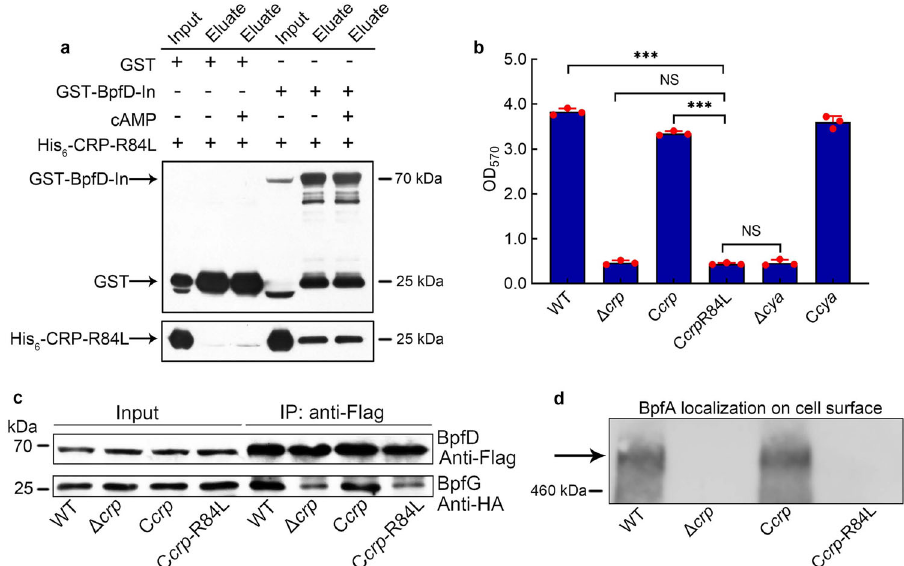
Fig. 6 cAMP is not necessary for physical interaction between CRP and BpfD, but it is essential to help CRP enhance the interaction between BpfD and BpfG. a GST pull-down assay showing the interaction between BpfD intracellular domains and CRP-R84L in vitro. b Bio fi lm biomass ( n = 3 independent samples). c Co-IP to analyze the interaction between BpfD and BpfG in vivo. d Western blotting detection of BpfA localization on the cell surface. All strains used in ( a , c , d ) were cultured for 30 h in the bio fi lm state. The native promoter region of the bpfA operon of the strains used in ( c , d ) was replaced by the constitutive promoter P aacC1 . Data in ( a ) are shown as the mean ± SD. Two-sided Student ’ s t test was used in ( a ) to analyze the statistical signi fi cance (NS: No signi fi cance. *** p < 0.001). Source data are provided as a Source Data fi